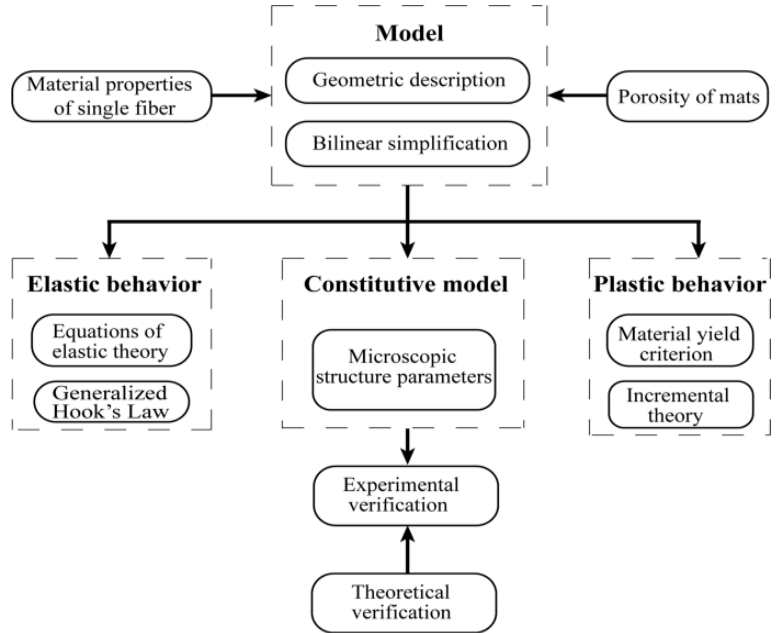
Figure 1. Methodology for the micromechanics constitutive model.